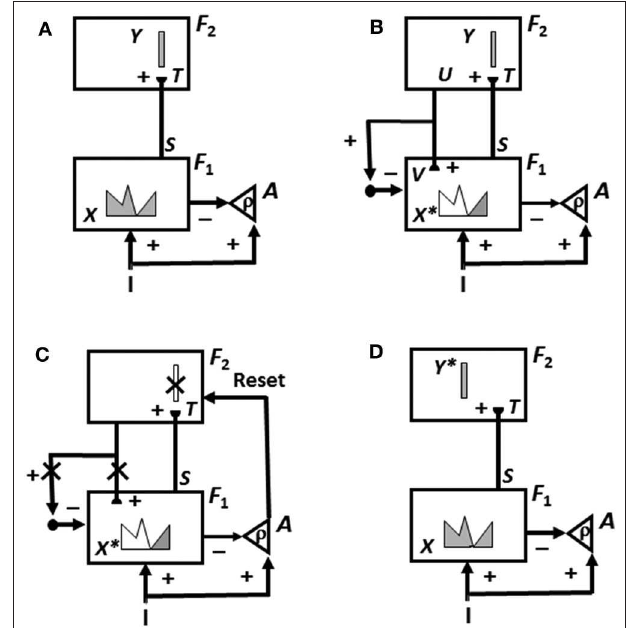
FIGURE 3 | The ART hypothesis testing and learning cycle whereby bottom-up input patterns that are sufficiently mismatched by their top-down expectations can drive hypothesis testing and memory search leading to discovery of recognition categories that can match the bottom-up input pattern well-enough to trigger resonance and learning. See the text for details [adapted with permission from Carpenter and Grossberg